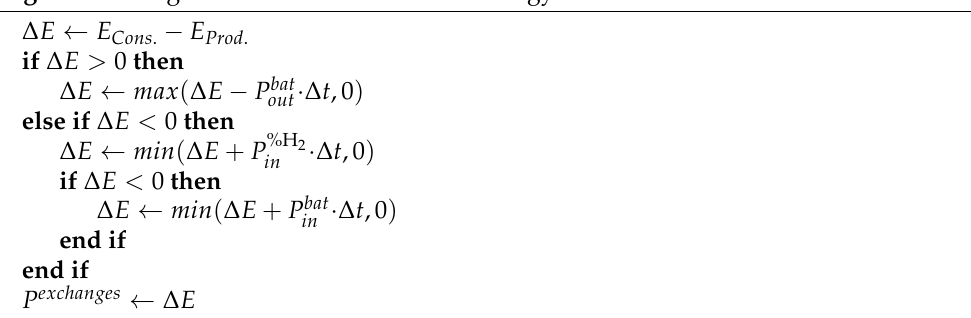
Algorithm 2 Algorithm of the second case